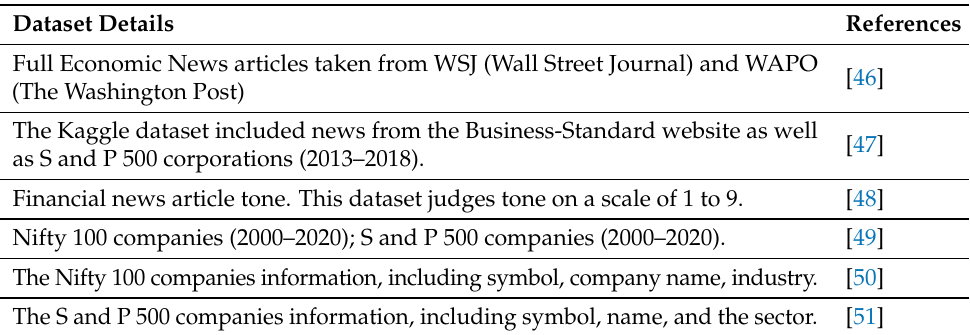
Table 4. Datasets used in this research